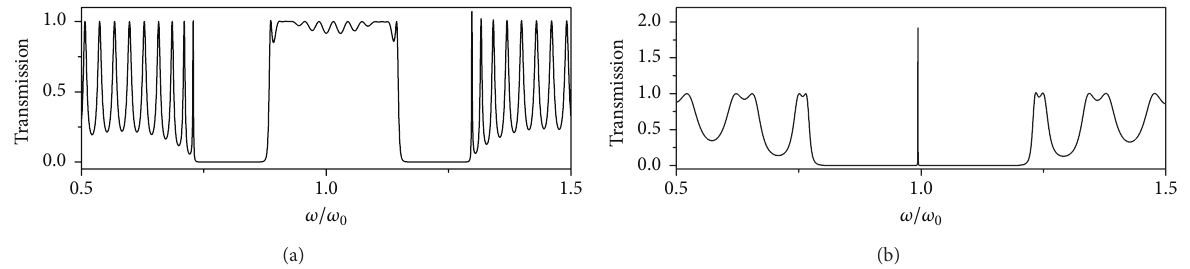
Figure 3: The quantum transmissivity of 1D PCs with 𝑛 𝑏 = 2 . 45 − 𝑖 0 . 0001. (a) The structure is (𝐵𝐵𝐴𝐵𝐵) 12 ; (b) the structure is (𝐵𝐴) 6 (𝐴𝐵) 6 .